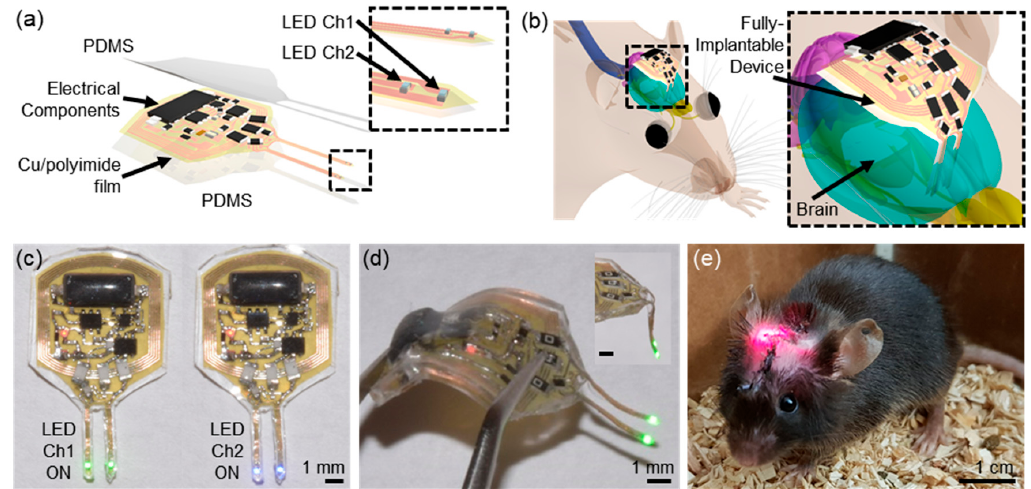
Figure 1. System overview. ( a ) Schematic illustration of a soft, fully implantable dual-channel optogenetic device. ( b ) Illustration of the device location relative to the brain. ( c ) Demonstration of a dual-channel wireless operation. ( d ) Picture of the device after bending the body of the device. ( e ) Image of a mouse with the device implanted. Table 1. Step by step procedures for the fabrication of the low-power, wireless optoelectronic devices.